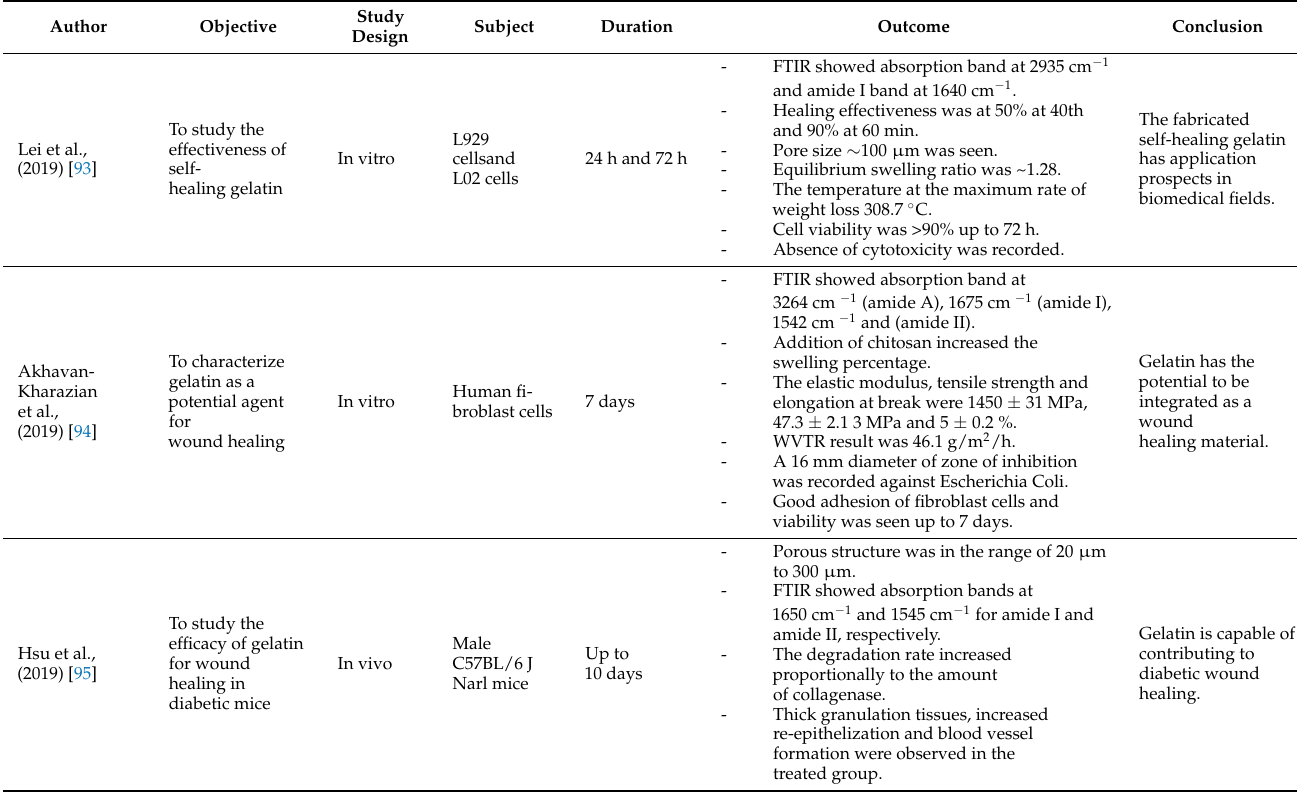
Table 4. In vitro and in vivo studies of gelatin for skin wound